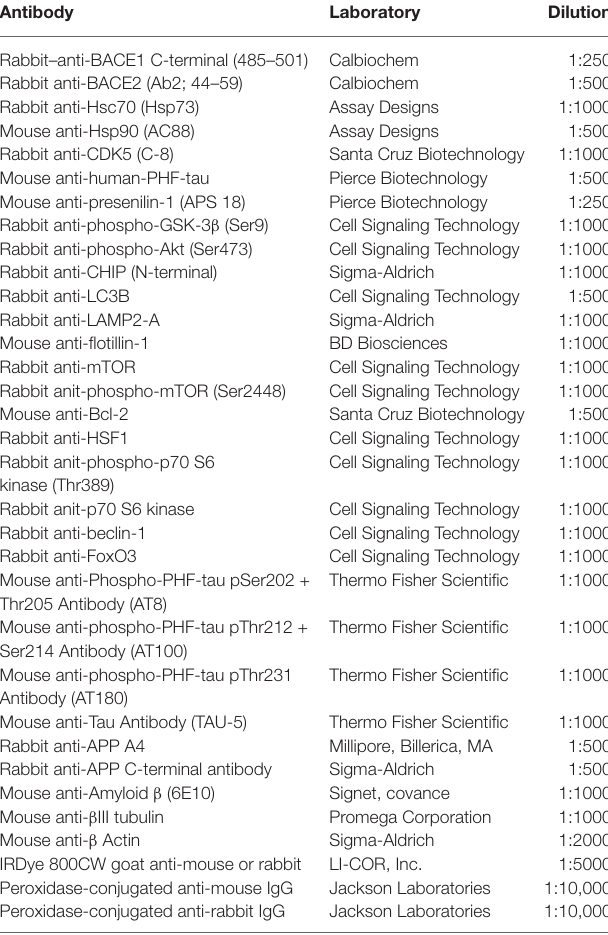
TABLE 1 | Antibodies